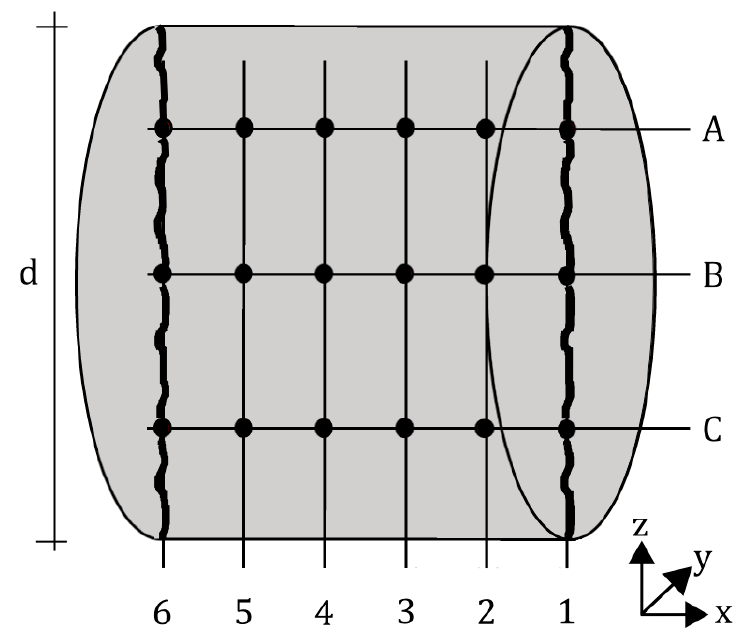
Figure 6. Position of measuring points within a